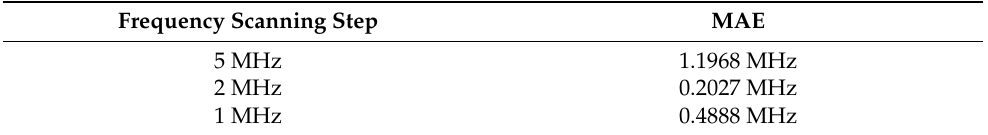
Table 4. MAEs of different frequency scanning steps.